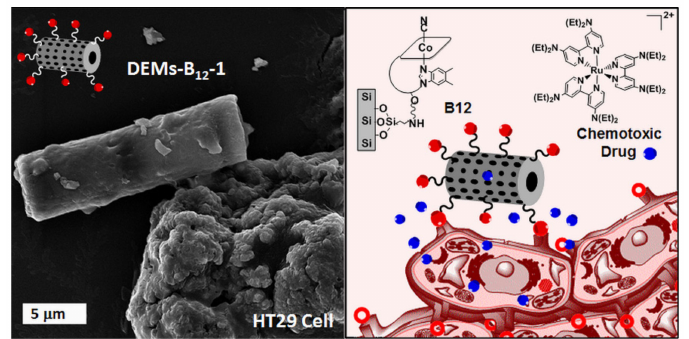
Figure 10. Schematic diagram showing: ( a ) structure of diatomaceous earth (DE) microparticles along with surface functionalization using organosilanes (APTES, GPTMS, OTS and mPEG-Silane) and phosphonic acid (2-CEPA and 16-PHA) to render DE surface either hydrophilic or hydrophobic; ( b ) scheme of the drug release from DE structure with chemical structure of the two model drugs IND—hydrophobic and GEN—hydrophilic used in this study. Reprinted from [64], copyright (2012), with permission from